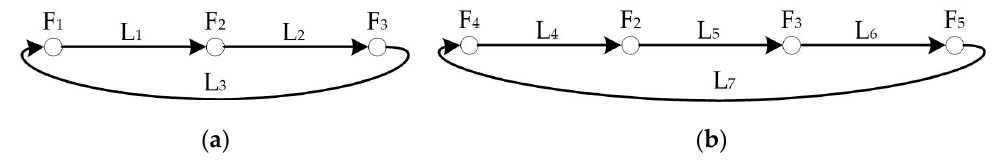
Figure 5. Two function chains ( a ) function chain G 1 ; ( b ) function chain G 2.